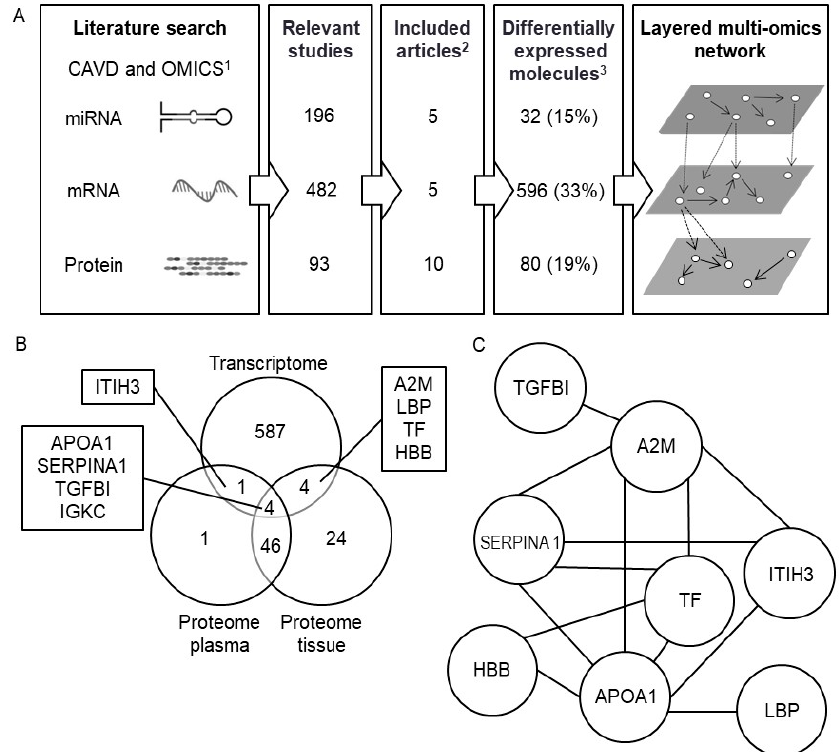
Figure 1. Dysregulated molecules in CAVD. ( A ) Workflow of the study. Literature search was performed for calcific aortic valve disease (CAVD) and omics. 1 microRNA (miRNA) and mRNA transcriptomics and proteomics. 2 Number of included articles after applying exclusion criteria. 3 Differentially expressed molecules in more than one study from miRNA, mRNA and protein single-omic studies. % indicate differentially expressed molecules from the total retrieved. ( B ) Venn diagram of the overlapping molecules between proteome and transcriptome datasets from plasma and tissue. ( C ) Protein–protein interaction (PPI) network of overlapping molecules between proteome and transcriptome using Search Tool for the Retrieval of Interacting Genes/Proteins (STRING). Immunoglobulin κ constant (IGKC) did not interact in the STRING network analysis. Apolipoprotein A1 (APOA1), β -globin (HBB), transferrin (TF), α -2-macroglobulin (A2M), transforming growth factor β -induced protein (TGFBI), serpin family A member 1 (SERPINA1), lipopolysaccharide binding protein (LBP), inter- α -trypsin inhibitor heavy chain 3 (ITIH3), immunoglobulin κ constant